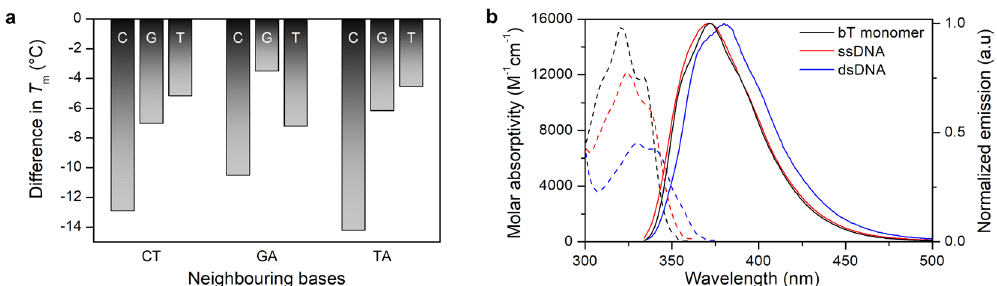
Figure 5. ( a ) Decrease in melting temperature upon base pairing bT with cytosine, guanine or thymine instead of adenine for three different sets of nearest bT neighbours (CT, GA and TA). The melting temperatures were calculated as the maximum of the first derivative of the UV-melting curves with a standard error of ≤ 0.6 °C. ( b ) Molar absorptivity (dashed) and normalized fluorescence (solid) spectra of the bT monomer ( 1 ) in water (black), bT-containing ssDNA (TT, red) and bT-containing dsDNA (TT, blue). Measurements were performed in phosphate buffer, pH 7.4, 150 mM Na +